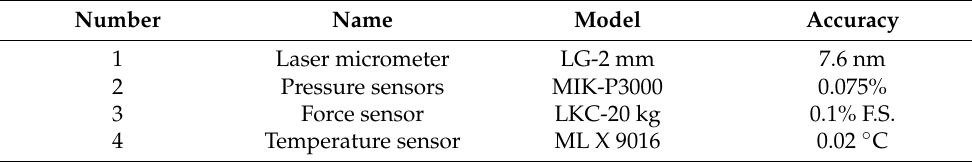
Table 4. The main measuring equipment used in the